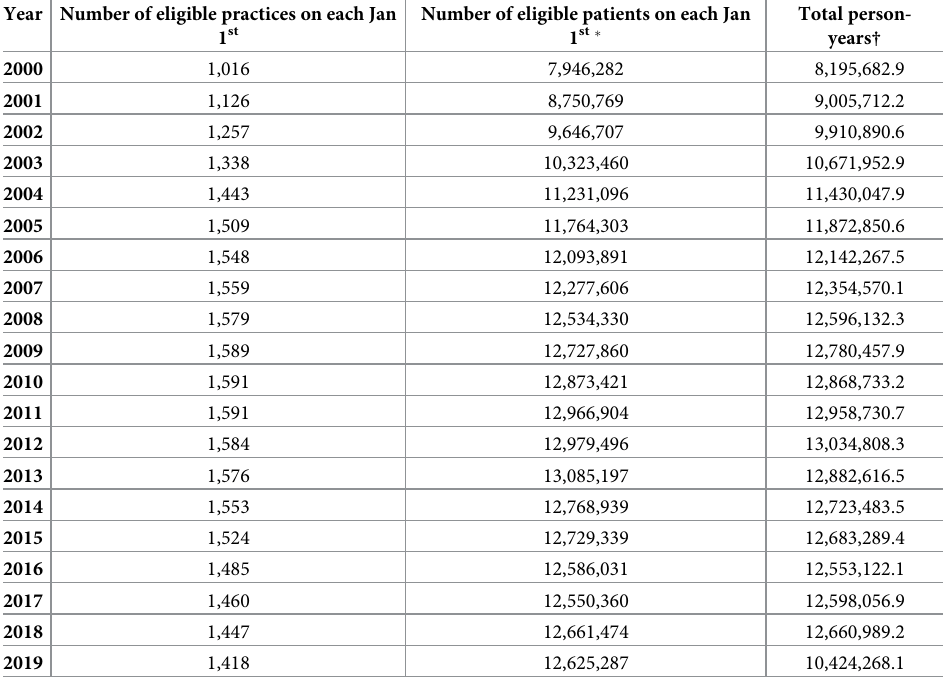
Table 1. Summary of annual denominators in harmonised CPRD